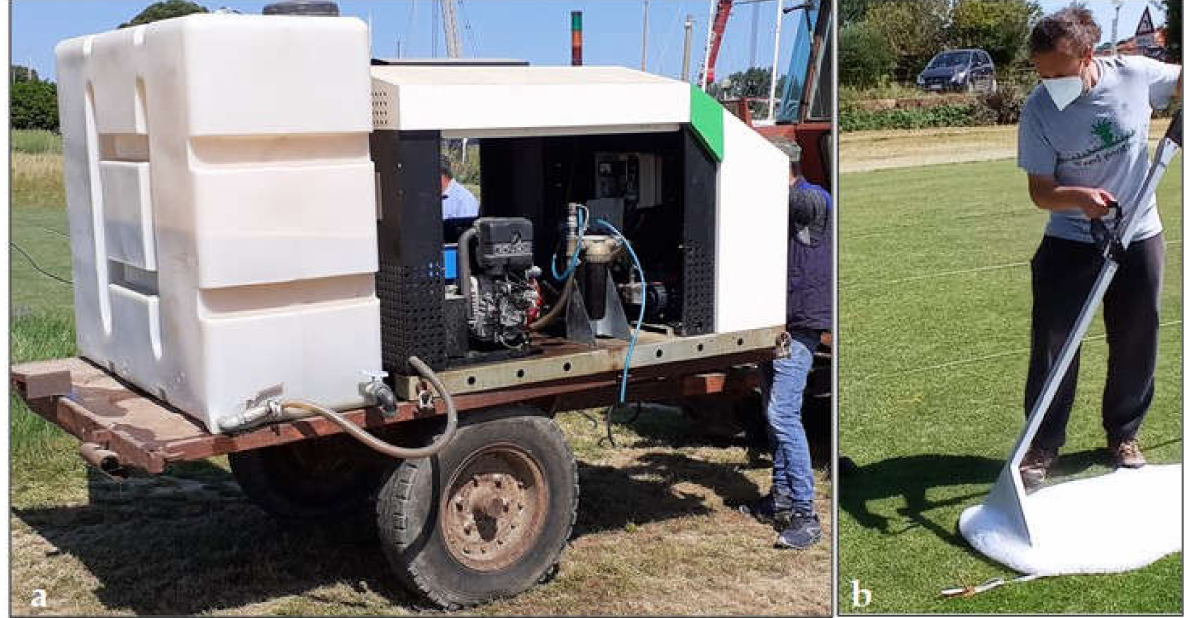
Figure 2. ( a ) Hot foam machine; ( b ) hot foam distribution with a handheld lance. On 1 June 2021, when all the plots treated with cool season turfgrass suppression methods had recovered at least 90% of their green cover, plant stress was determined by the measurement of normalized difference vegetation index (NDVI) and dark green color index (DGCI). NDVI readings were collected with a handheld crop sensor (GreenSeeker Model HSC-100, Trimble Navigation Unlimited, Sunnyvale, CA). DGCI and GLI